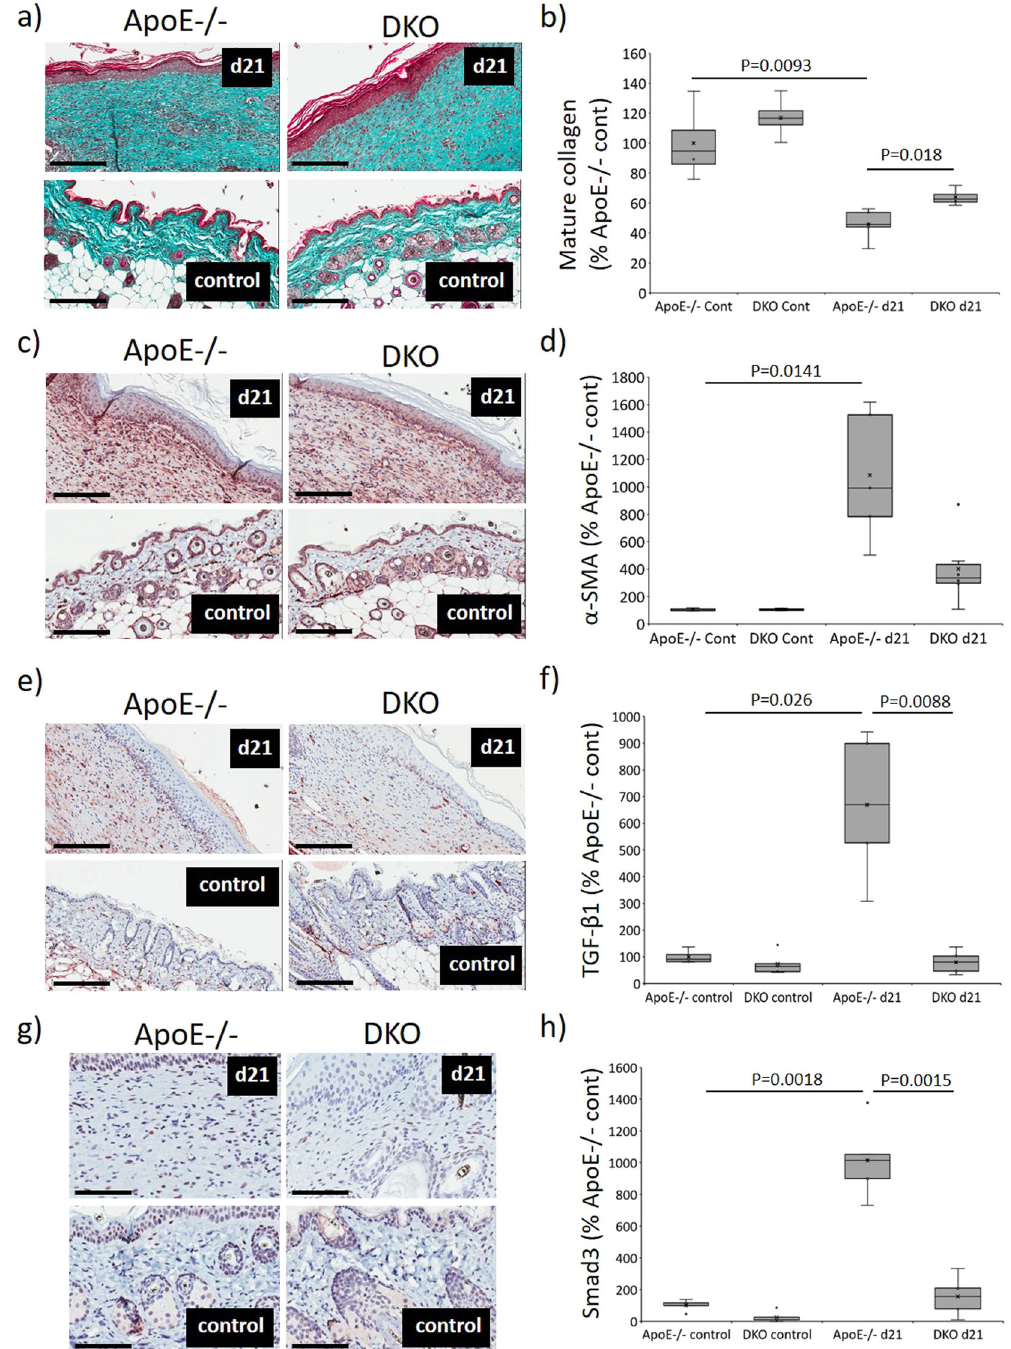
( b ), α -SMA ( d ), TGF- β 1 ( f ), and Smad3 ( h ). Data analyzed by two-way ANOVA with Bonferonni post-test and presented as a percentage of ApoE − / − control, n = 4 samples per